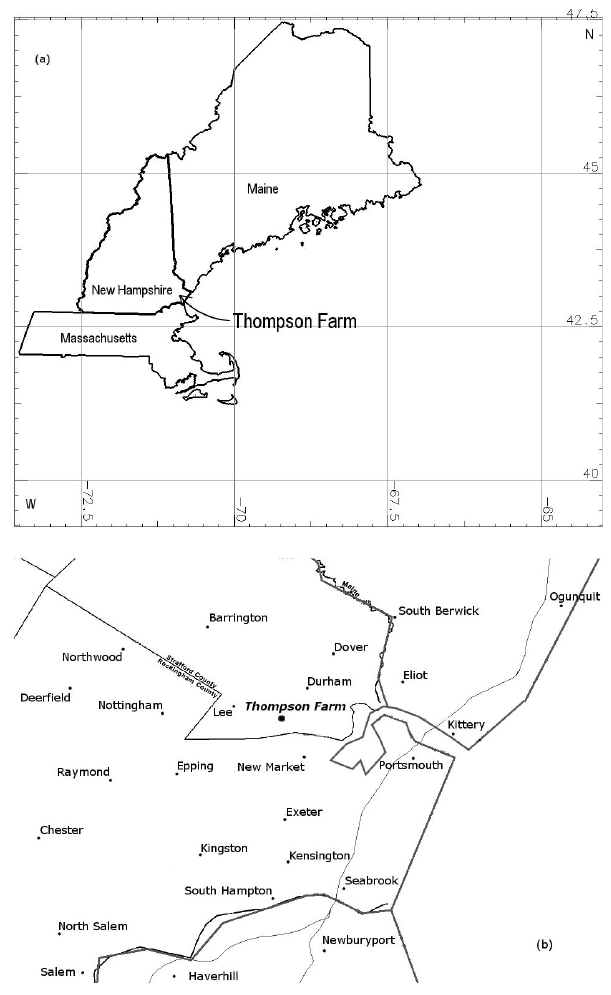
Fig. 1. (a) The location of Thompson Farm with respect to the New England region, (b) Expanded view of the measurement